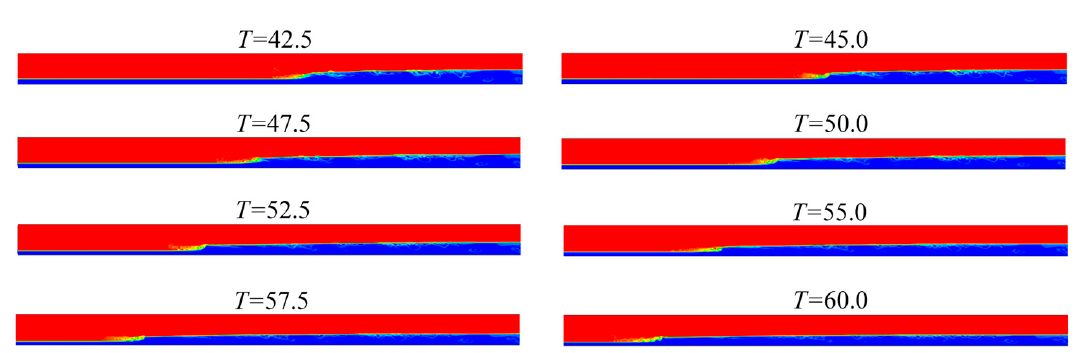
Figure 16. Free surface at T = 42.5–60.0.